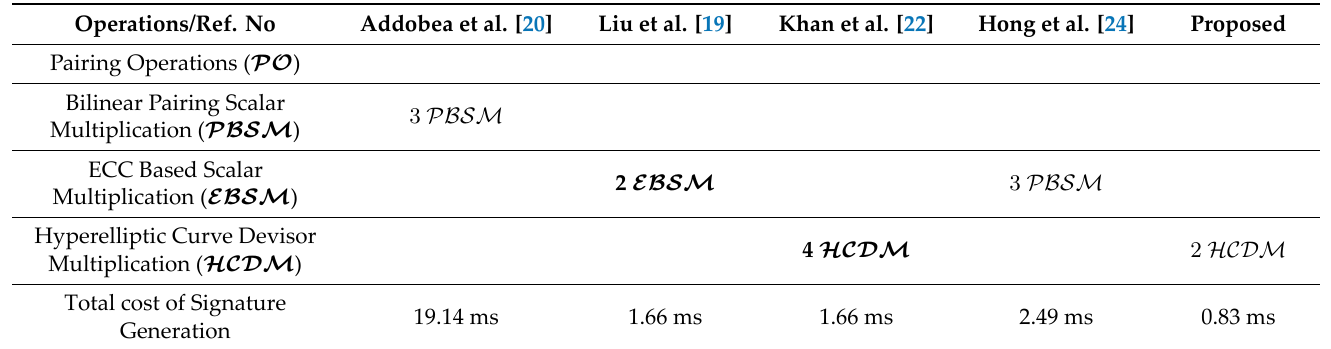
Table 4. Computation of the costs of both online and offline signature generation.